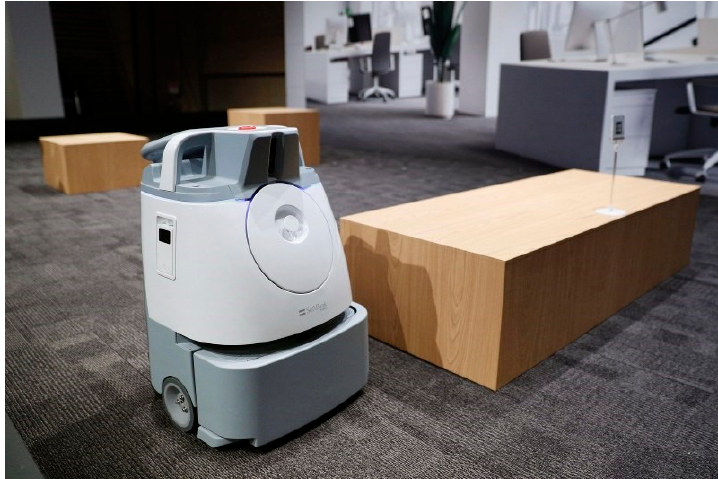
Figure 8. A sample of a vacuum robot faced with regular and irregular obstacles.